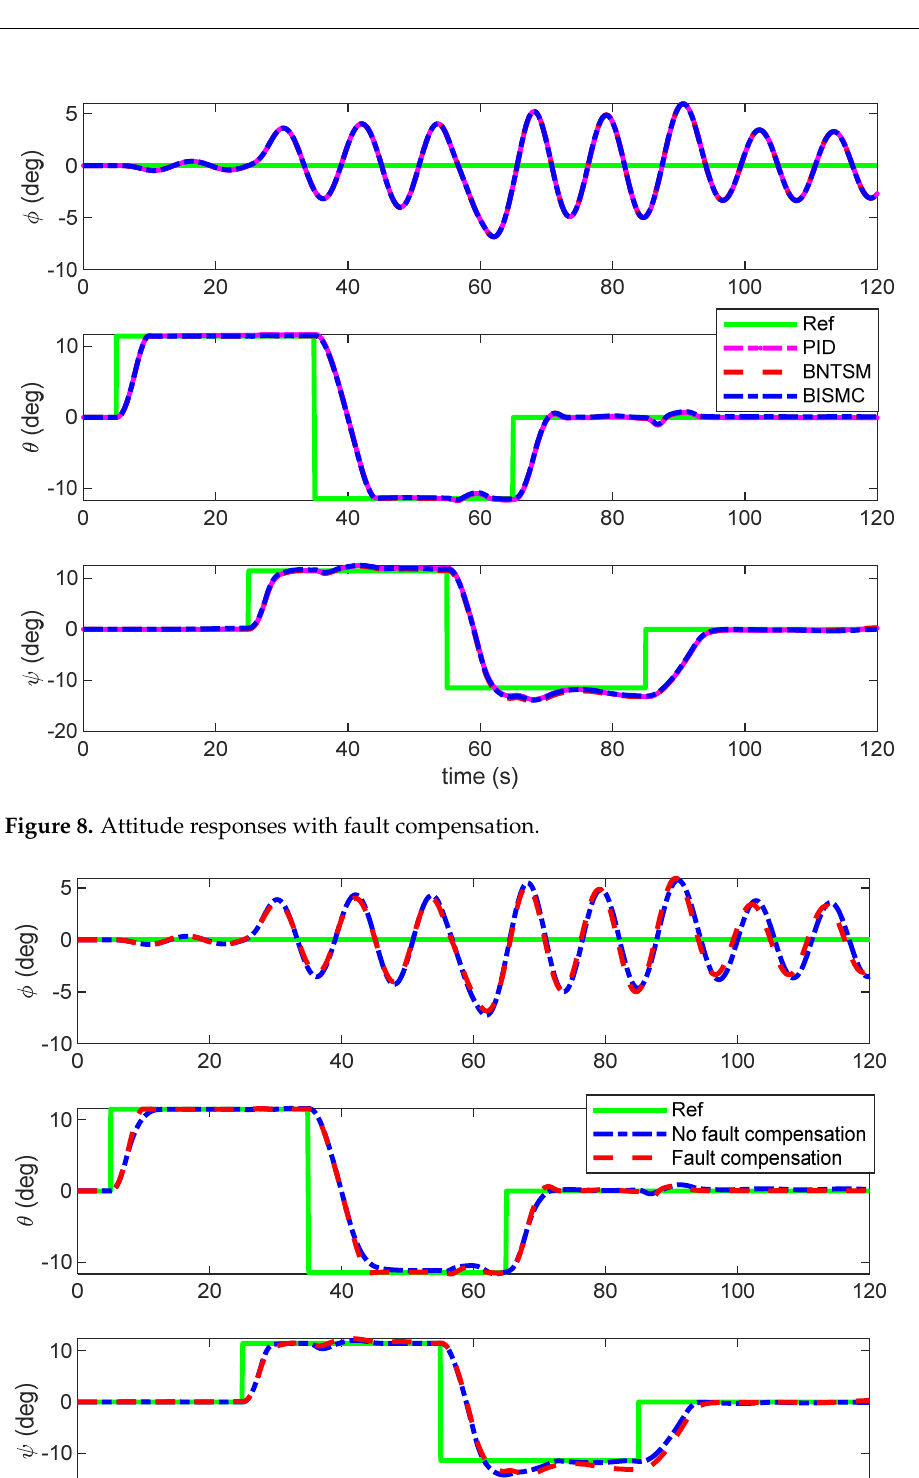
Figure 10. Control inputs with faults.